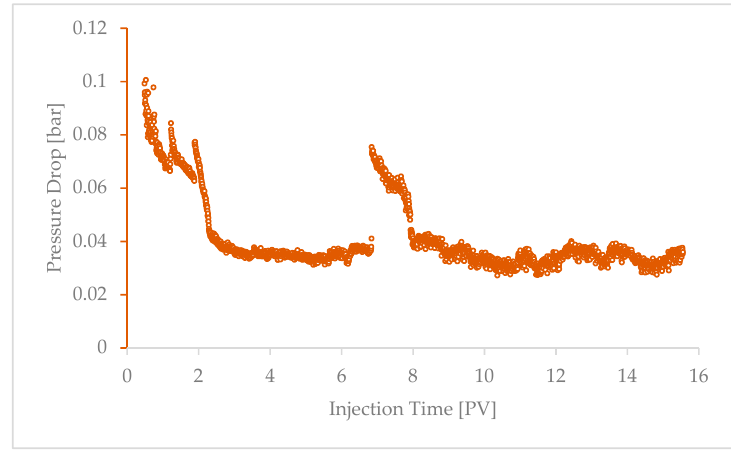
Figure 5. Pressure drop profile recorded during injection of carbonated water into a Bentheimer core at a flow rate of 0.25 mL/min at 80 bar and 60 °C. The pressure drop is seen to fall sharply until about 3 pore volumes (PV), stabilizes between 3 PV and about 7 PV, and become very unstable